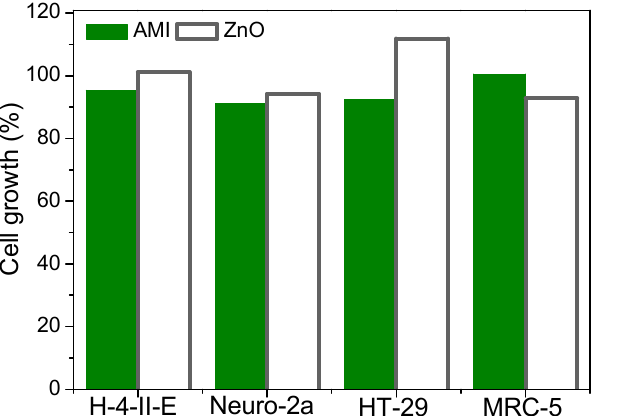
Figure 10. Cytotoxic activity of AMI (0.0300 mmol/L) and the blank probe ZnO (1.0 mg/mL) on the investigated cell lines.